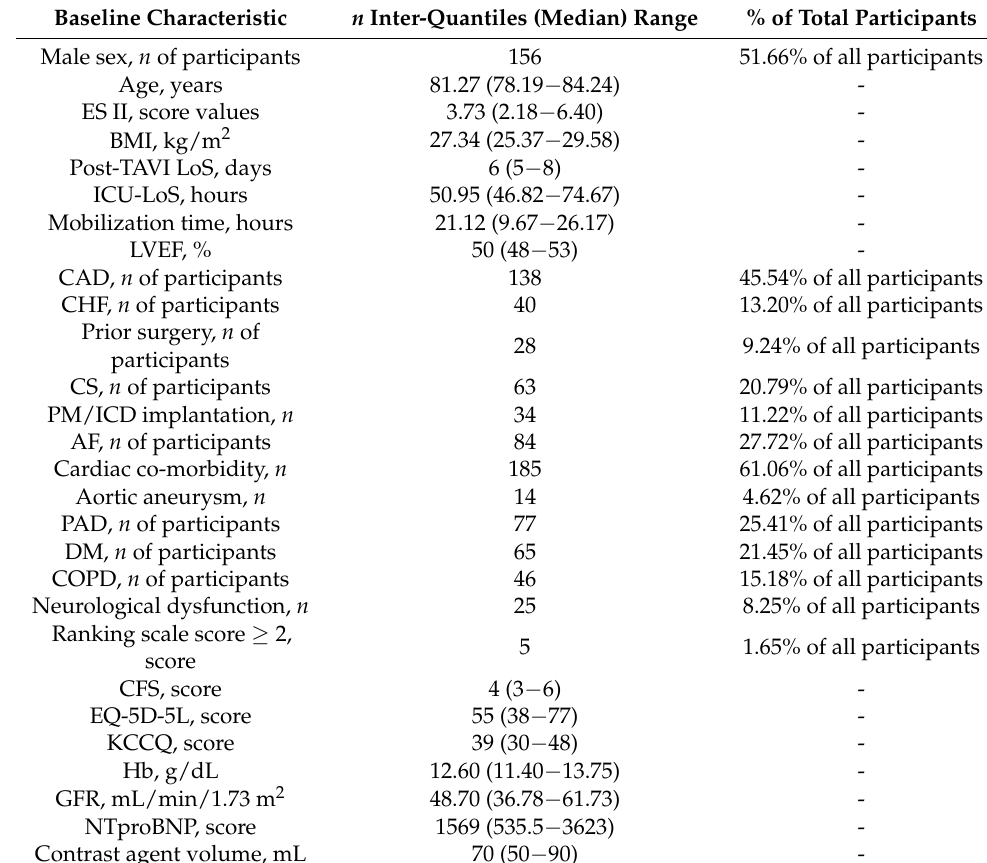
Table 1. Baseline characteristics of the study participants (number n =